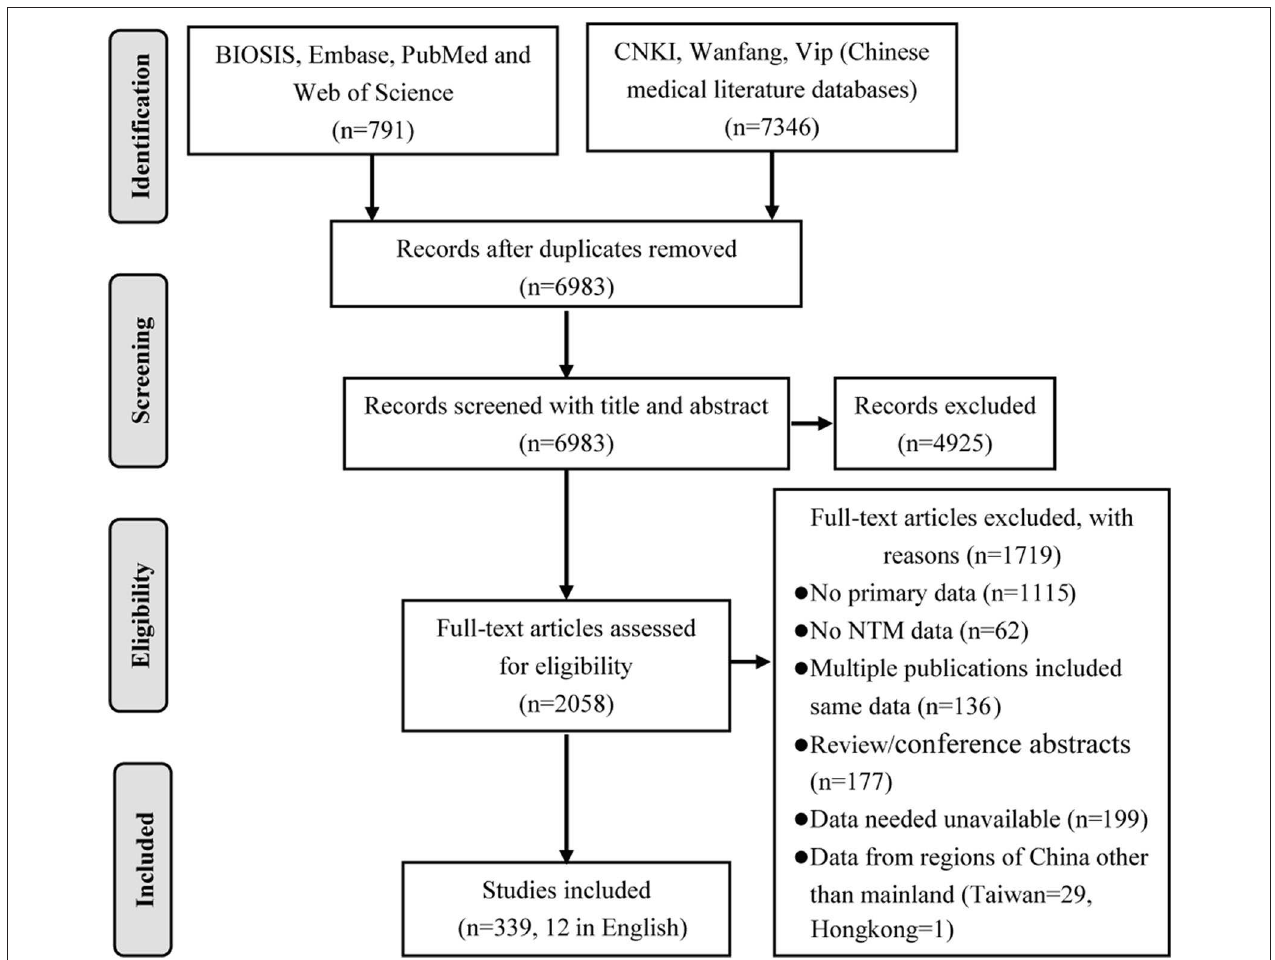
FIGURE 1 | Preferred Reporting Items for Systematic Reviews and Meta-Analyses flow diagram.